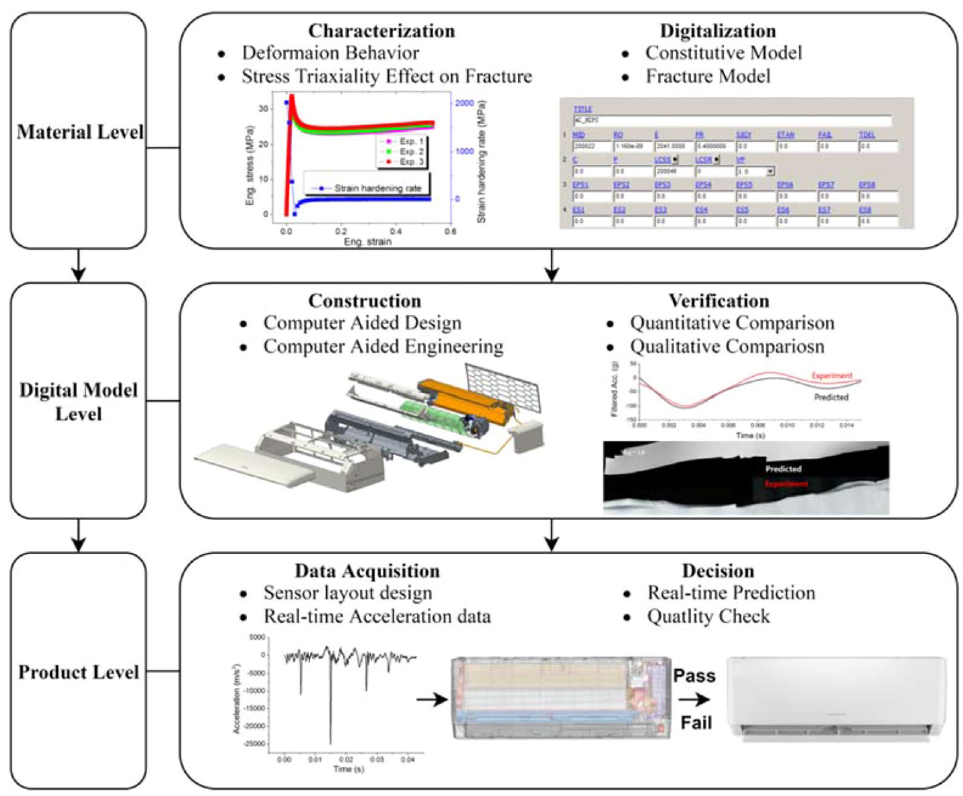
Figure 1. Schematic diagram showing structure of the digital twin of an air conditioner under mechanical stimuli.